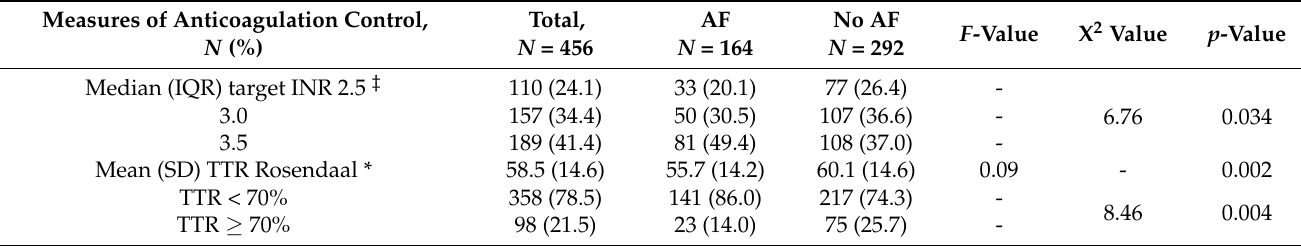
Table 2. Measures of anticoagulation control of patients with operated valvular heart disease, with and without